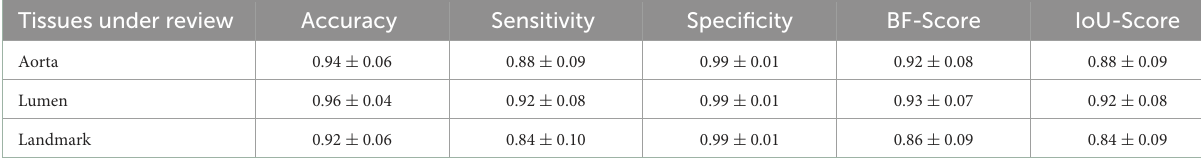
TABLE 3 Measured accuracy, sensitivity, specificity, BF-score, and IoU-score to evaluate the model performance on 19 different patients, which were not included in any of the training, test, and validation sets and were only used for algorithm verification.